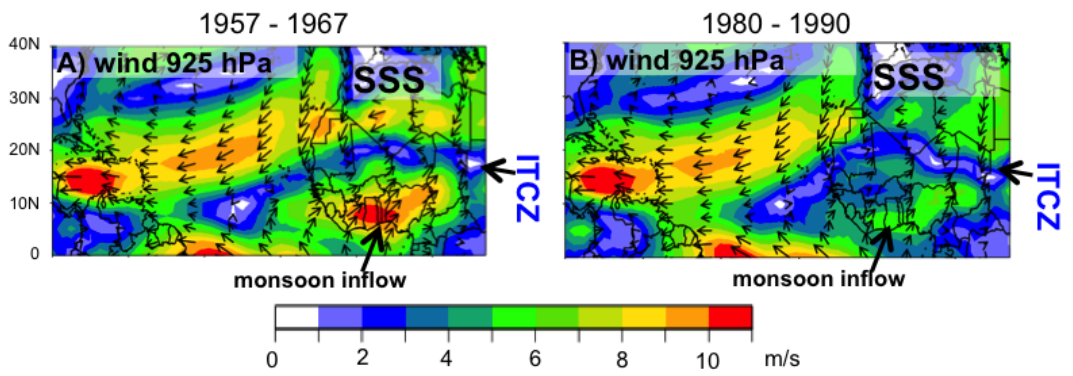
Figure 9. Mean winds at 925hPa ( ≈ 800ma.s.l.) in the 1957–1967 (plentiful rains in the Sahel) and 1980–1990 (severe Sahelian drought)